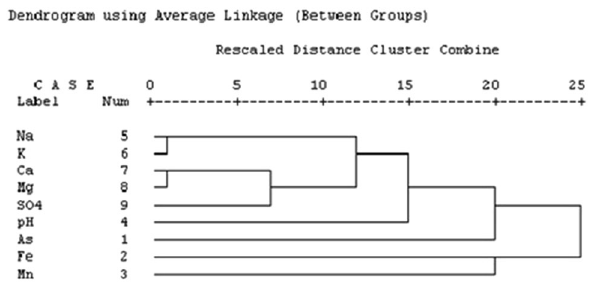
Fig. 6 Dendrogram showing the clusters of different water quality parameters in the wet season